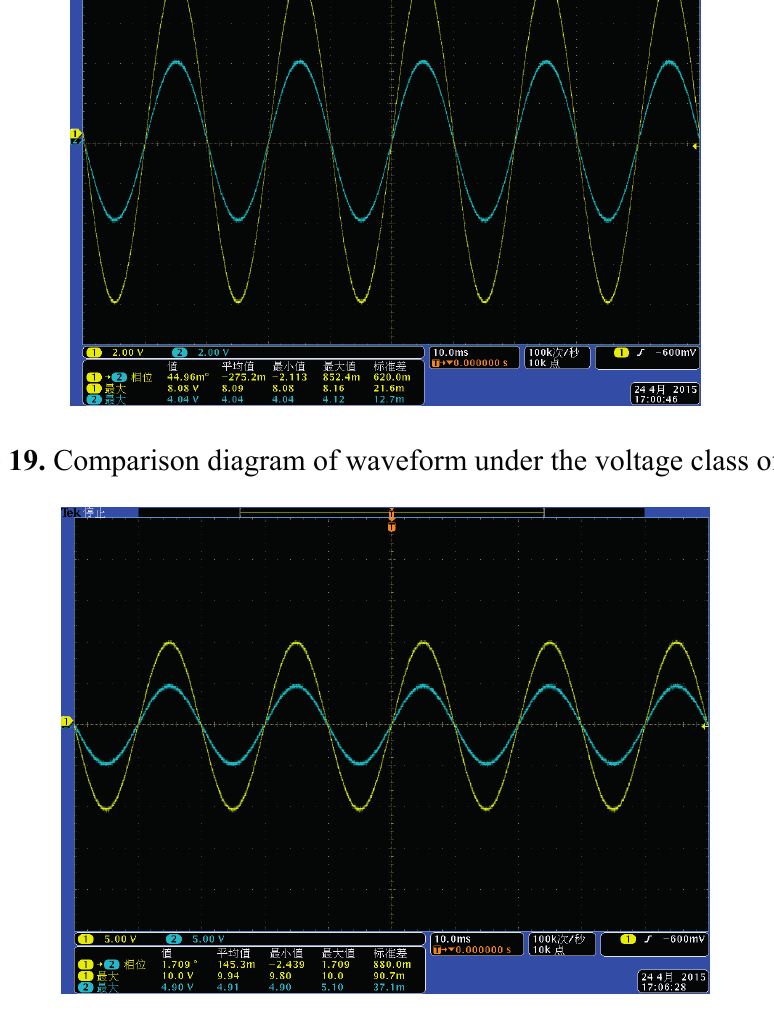
Figure 20. Comparison diagram of waveform under the voltage class of 8